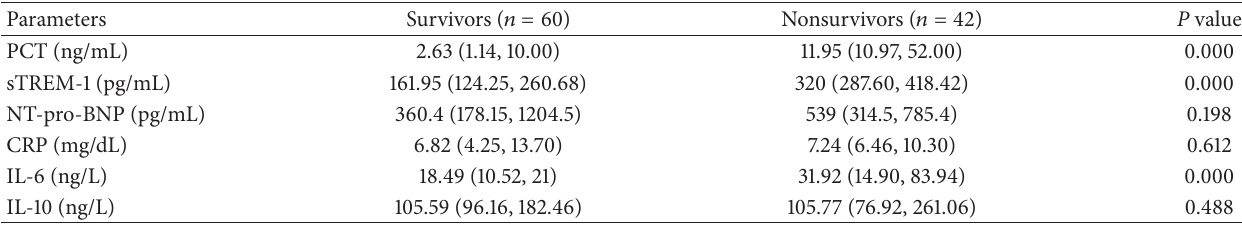
Table 2: Comparison of serum biomarkers and cytokines levels on day